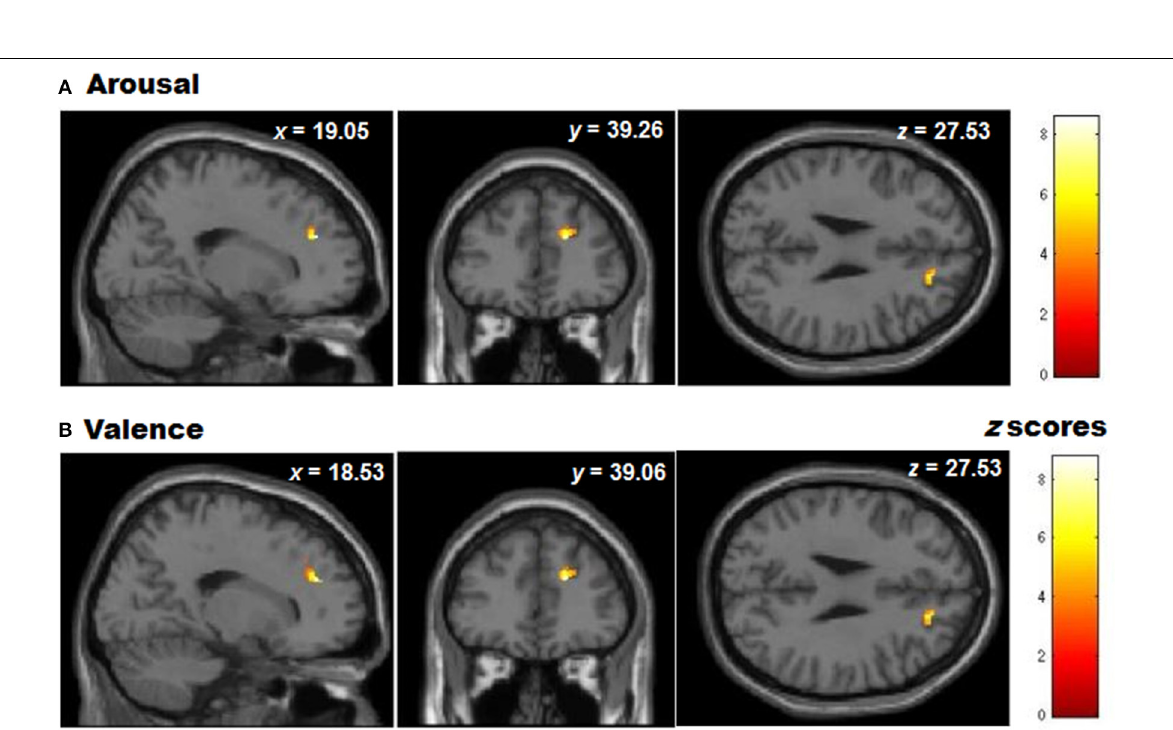
Frontiers in Behavioral Neuroscience